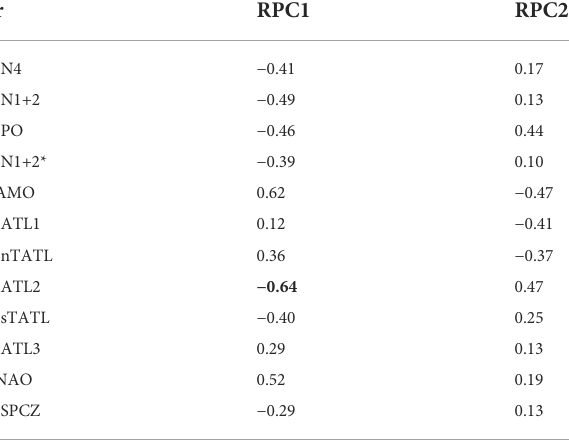
TABLE 1 DJF Pearson correlation coef fi cients between the fi rst two RPCs of the interdecadal component of the DJF precipitation anomalies over the Central Andes with the Interdecadal Niño 4 (IN4) index, Interdecadal Niño 1 + 2 (IN1+2) index, Interdecadal Paci fi c Oscillation (IPO), Interdecadal Niño 1 + 2 index with the Niño 3.4 in fl uence removed (IN1+2*), Atlantic Multidecadal Oscillation (AMO), the fi rst three rotated principal component of the interdecadal variability of the SST anomalies over the Atlantic SST (IATL1, IATL2 and IATL3), Interdecadal tropical South Atlantic (ItSATL)index, Interdecadal tropicalNorth Atlantic (ItNATL) index, Interdecadal North Atlantic Oscillation (INAO) index and Interdecadal South Paci fi c Convergence zone (ISPCZ) index. Values statistically signi fi cant at 95% are shown in bold. Analysis based on the 1921 – 2010